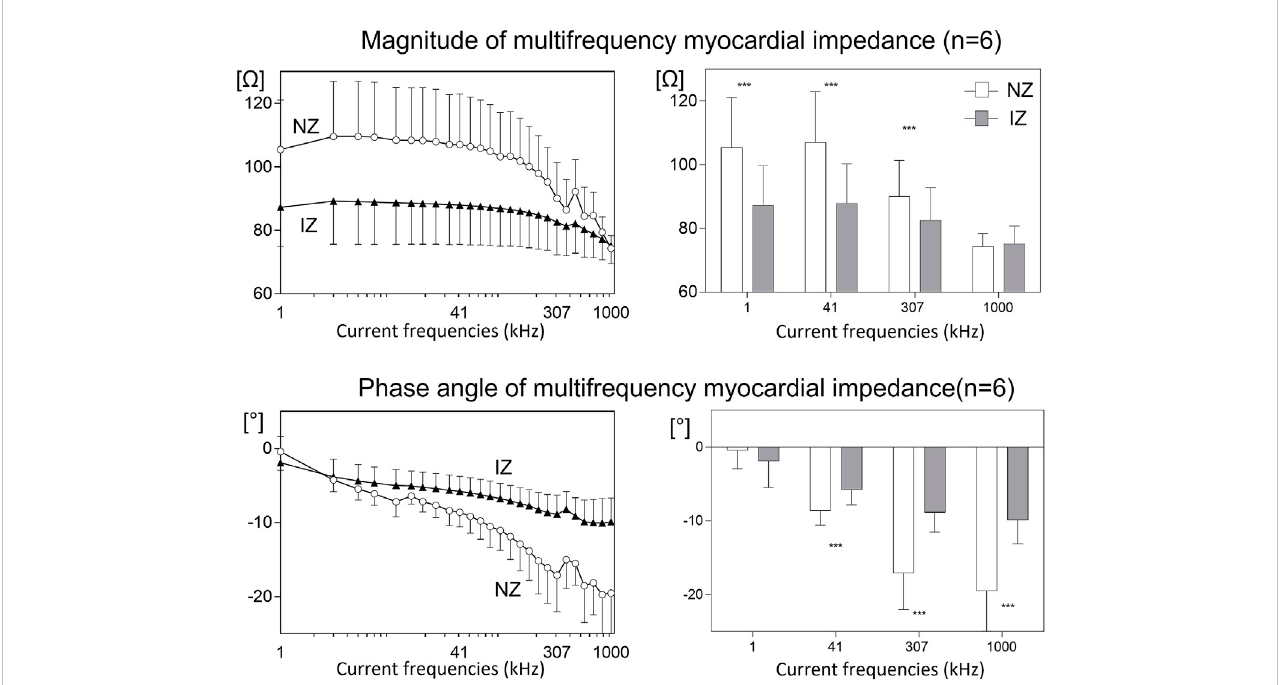
FIGURE 4 Mean values of the impedance magnitude and phase angle at multifrequency in 6 pigs submitted to acute transcatheter occlusion of the atrial coronary artery branches arising from the proximal segment of the left circum fl ex coronary artery. The left panels show the mean changes in atrial myocardial impedance magnitude (upper) and phase angle (lower at 26 studied current frequencies. The right panels show the mean changes in atrial myocardial impedance magnitude (upper) and phase angle (lower) at four selected current frequencies. NZ: normal zone; IZ: infarcted zone; ***: ANOVA p < .001 between myocardial impedance NZ and IZ areas.